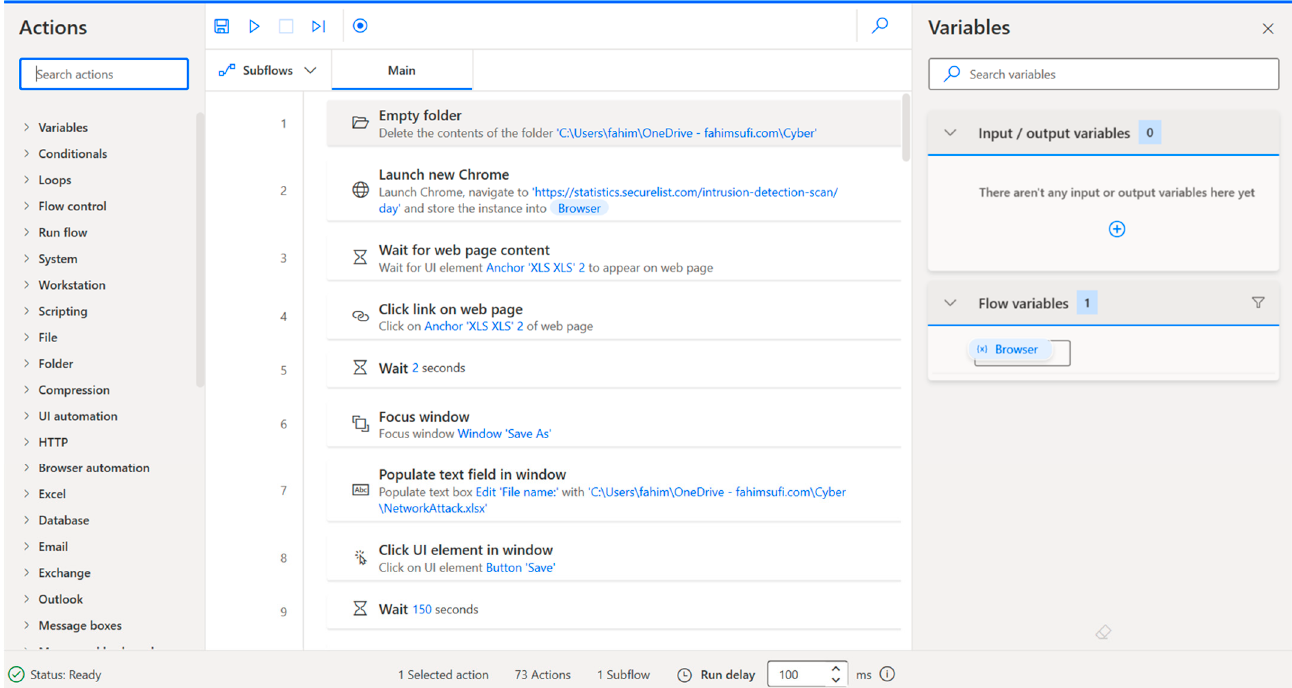
Figure 3. Aggregation of cyber ‐ attack data from multiple sources using Microsoft Power Automate Desktop UI flow [57].